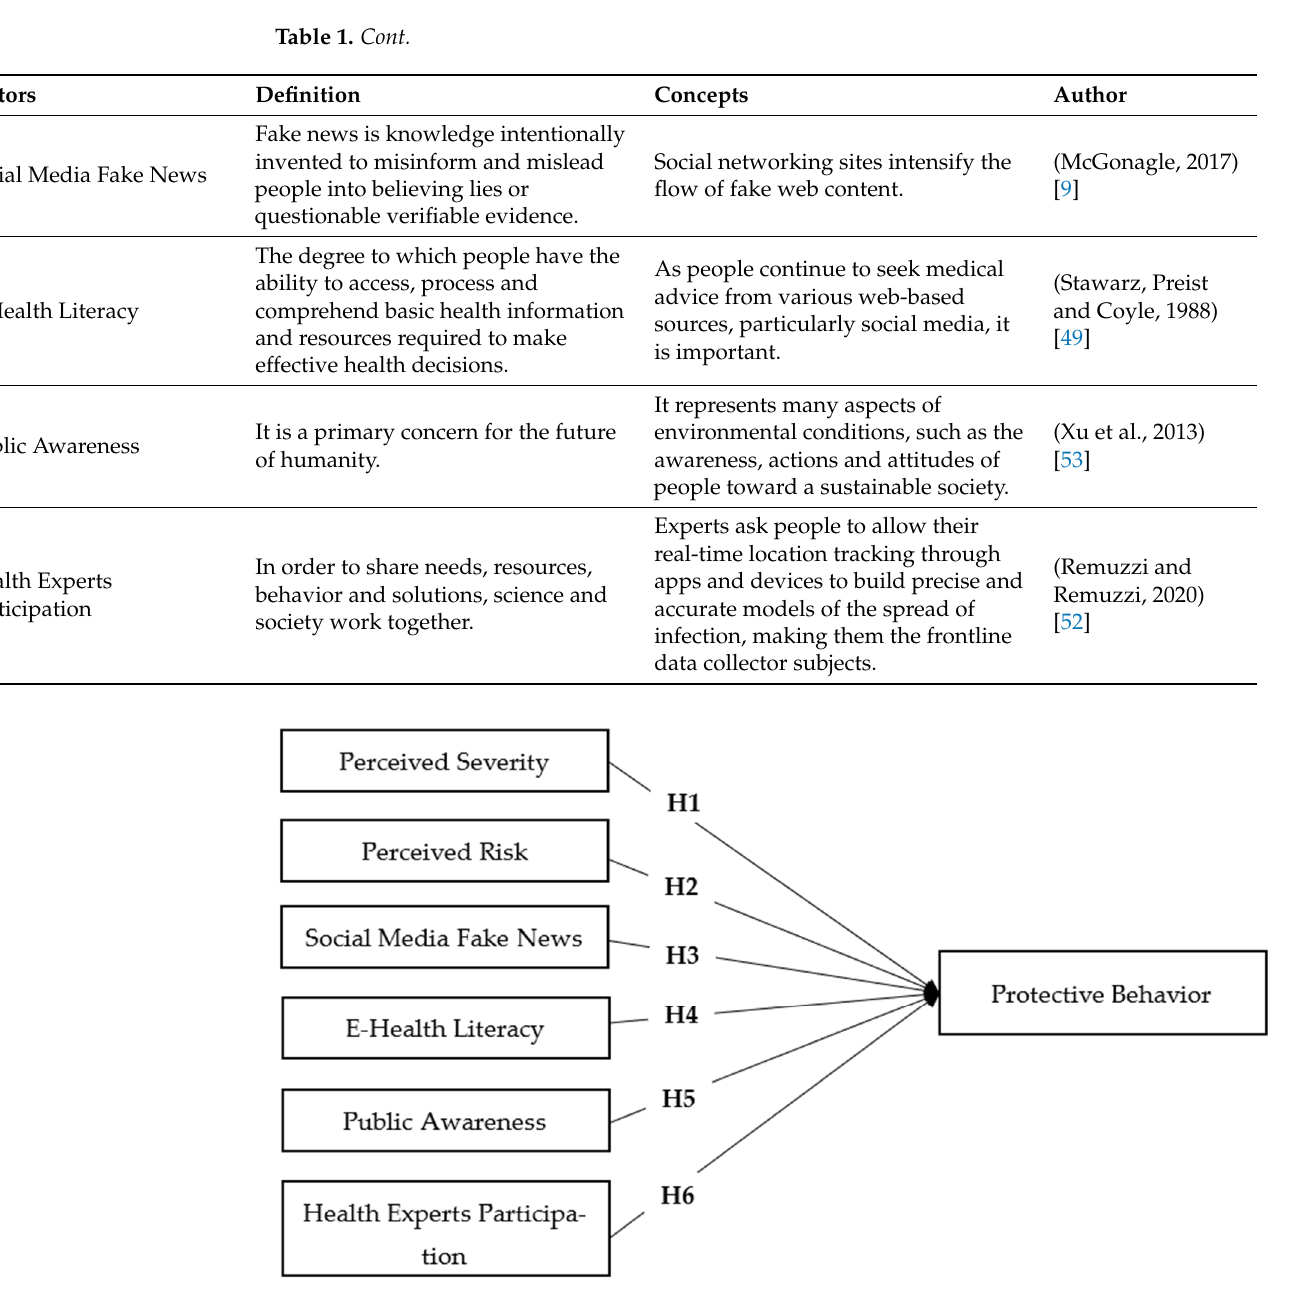
Figure 1. The Study Research